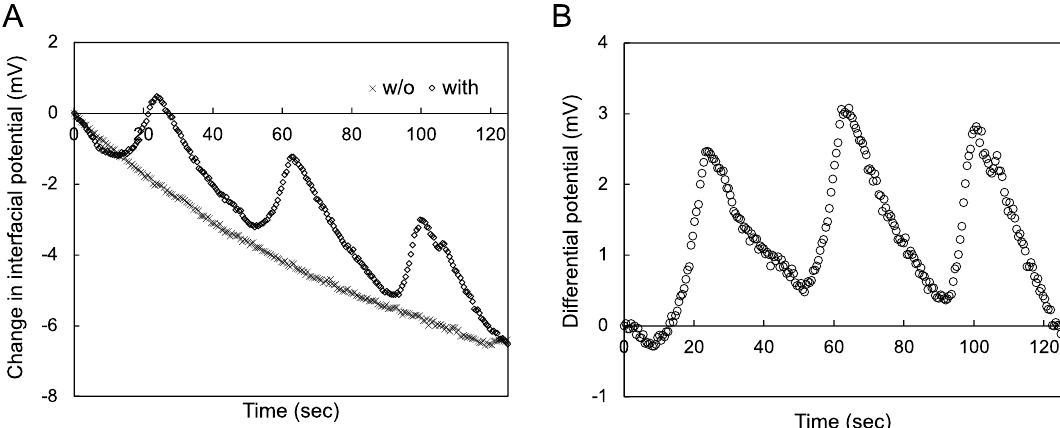
Figure 6. Electrical monitoring of self-oscillating polymer brush grafted on Ta 2 O 5 gate insulator using single- gate ISFET sensor. ( A ) Electrical signals for single-gate ISFET sensors with and without self-oscillating polymer brush. ( B ) Differential signal based on ( A